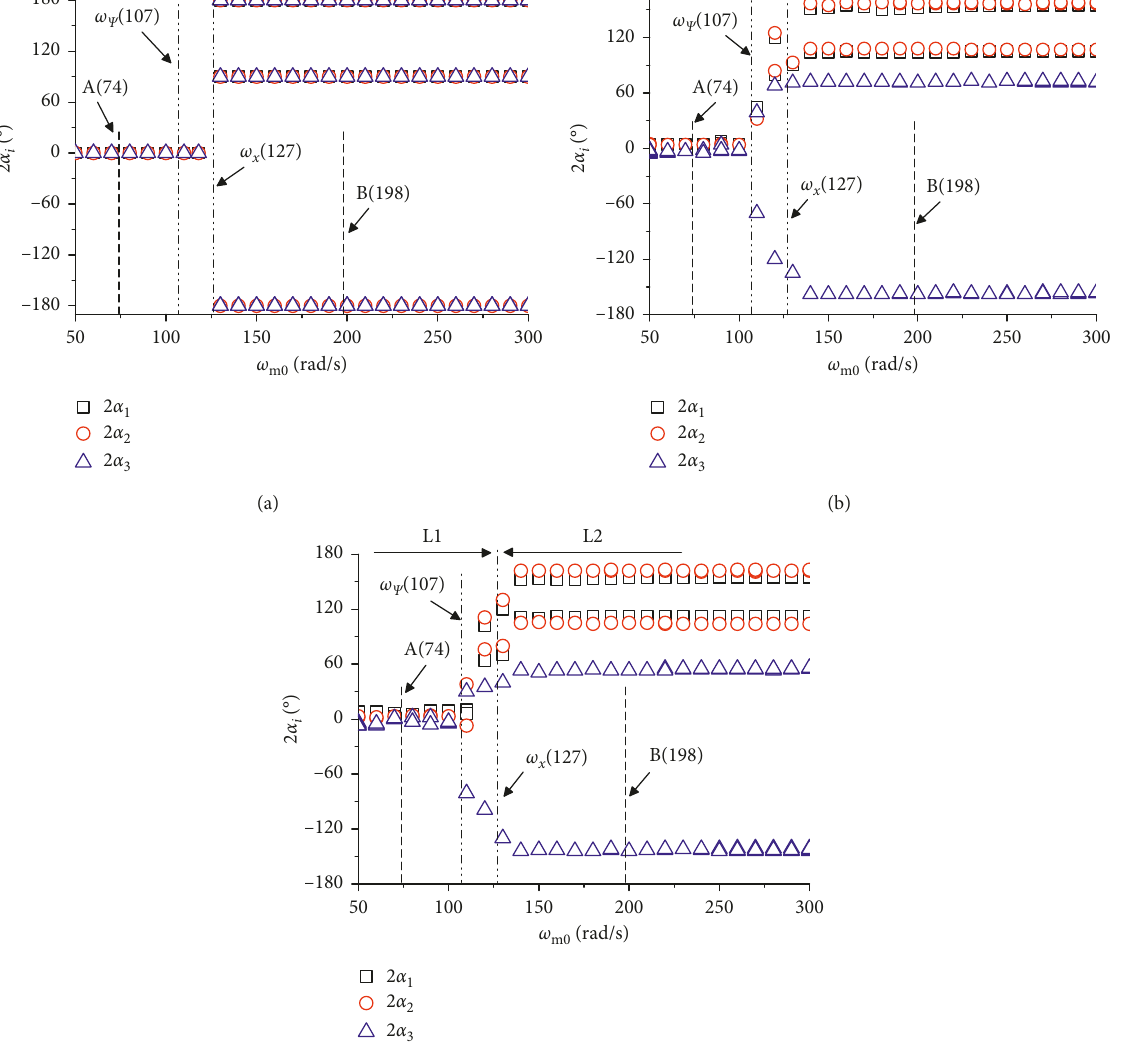
i 1 , 2 , 3 , 4 i ( (cid:31)